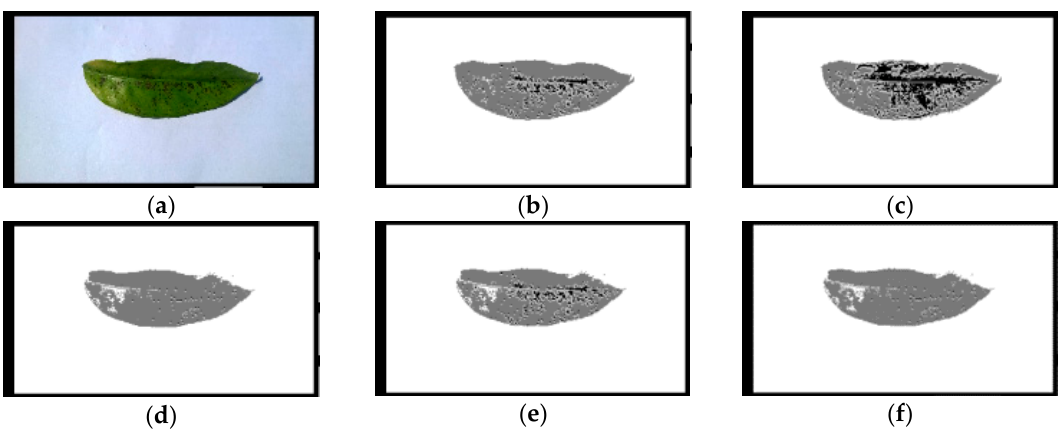
Figure 3. Spot separation for a leaf (upper surface) infected by the fungus Diaporthe citri of melanose. Original image ( a ), spot separation method (SSM)1 with T h = 20, B g = 130 ( b ), SSM1 with T h = 10, B g = 130 ( c ), SSM1 with T h = 30, B g = 130 ( d ), SSM2 ( e ), SSM3 ( f ).